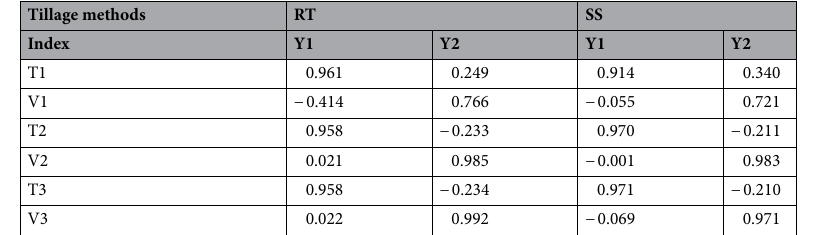
Table 6. Parameter factor analysis of grain filling rate. The extraction method was principal component analysis, Y1 represents the grouting duration, and Y2 represents the average grouting rate. T1 represents the grain filling duration of the gradually increasing stage, V1 represents the average grain filling rate of the gradually increasing stage, T2 represents the grain filling duration of the rapidly increasing stage, V2 represents the average grain filling rate of the rapidly increasing stage, T3 represents the grain filling duration of the slowly increasing stage, and V3 represents the average grain filling rate of the slowly increasing